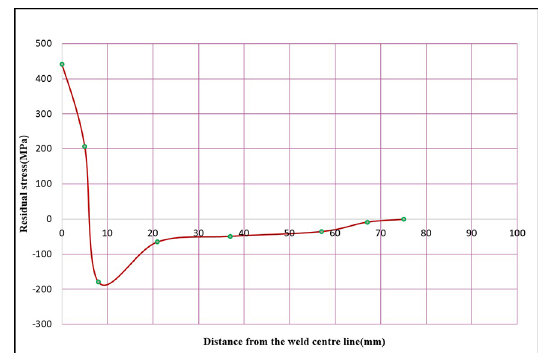
Figure 12. Residual stress distribution in transverse direction.